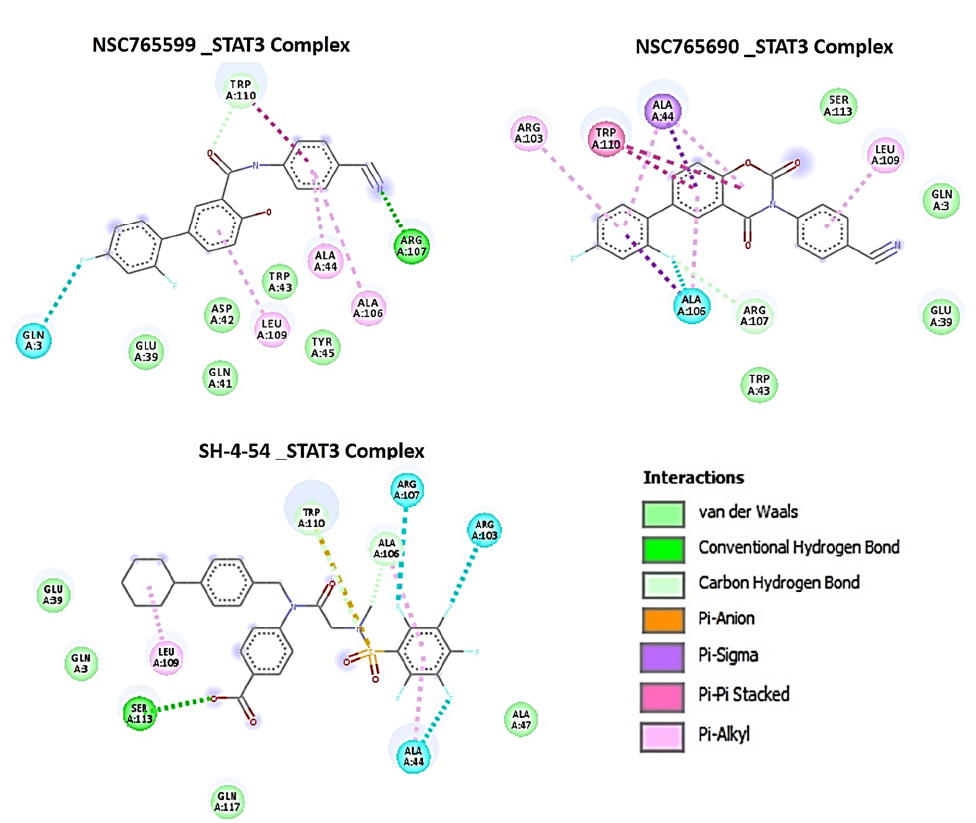
Figure 8. Comparative docking profiles of STAT3 with NSC765599, NSC765690, and SH-4-54 (a known STAT3 inhibitor). A 2D representation of ligand–receptor interactions of STAT3 with NSC765599, NSC765690, and SH-4-54 in the receptor binding pocket.